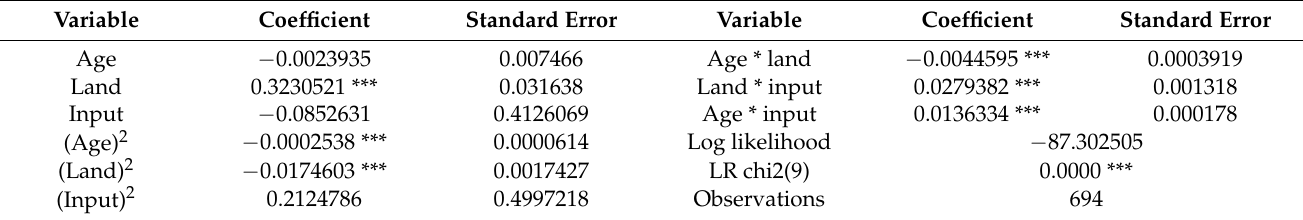
Table 2. Tobit model estimation